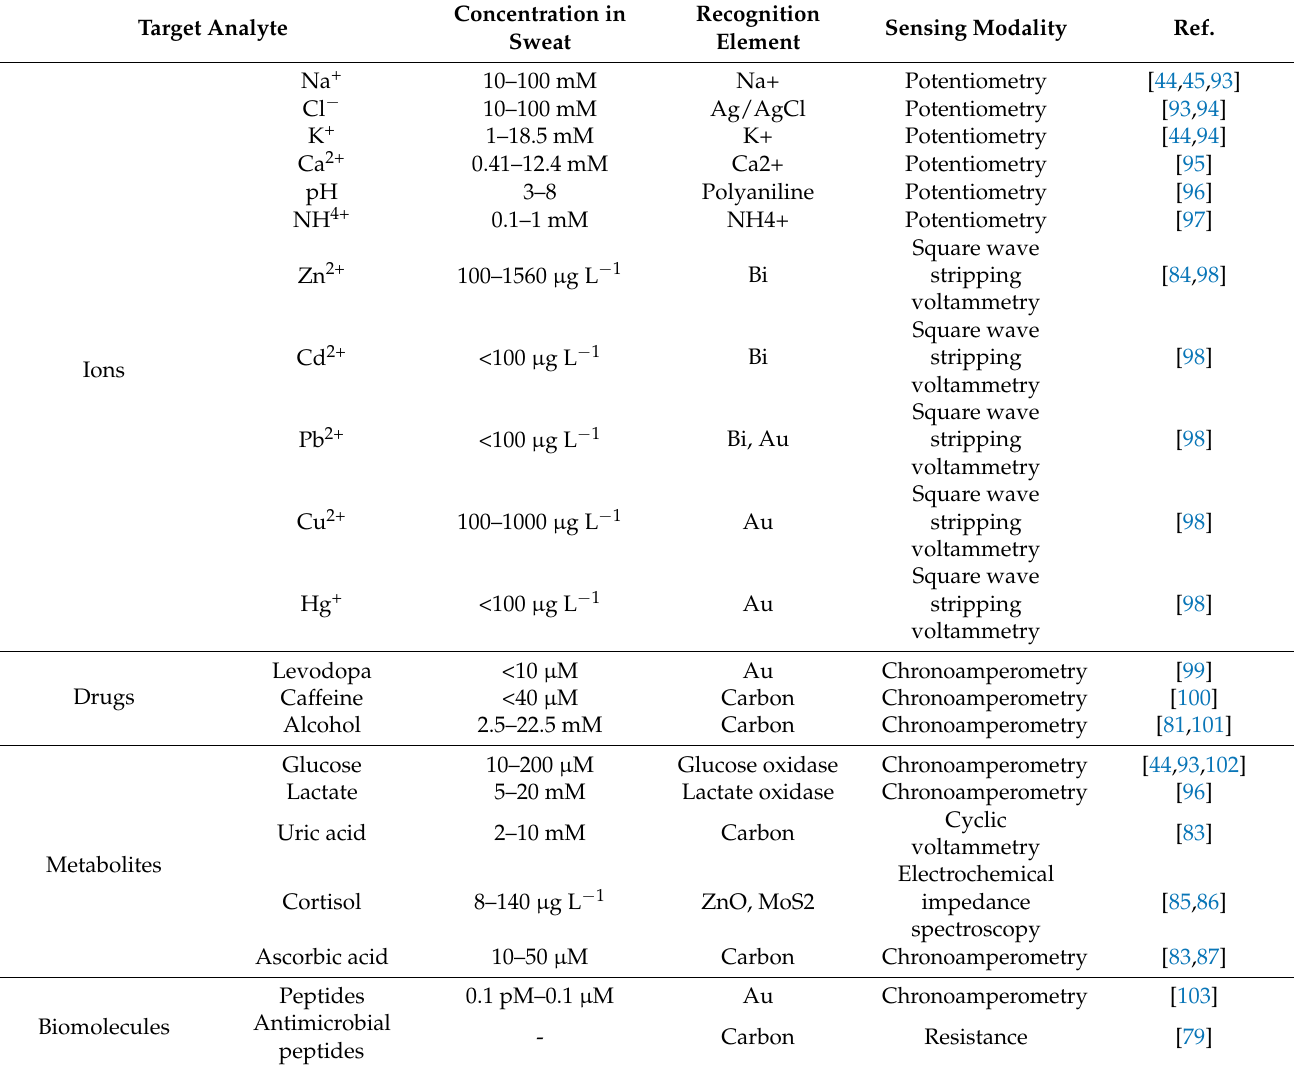
Table 1. Key analytes in sweat and the related detection